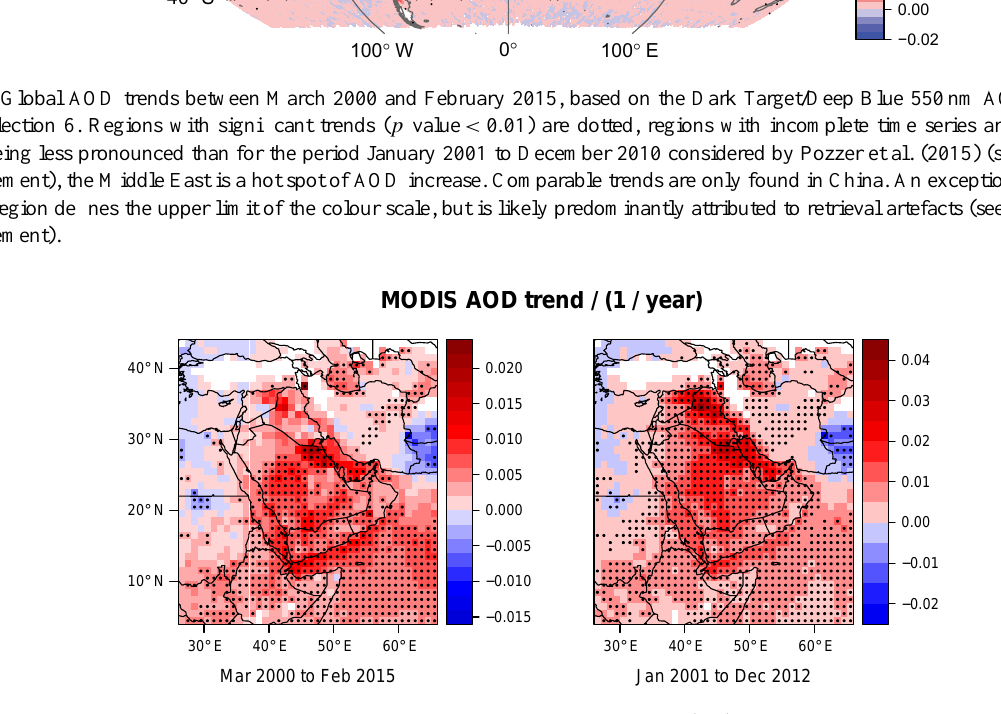
Figure 2. Pattern of Middle East AOD trends between March 2000 and February 2015 (left) and between January 2001 and December 2012 (right), based on the Dark Target/Deep Blue 550nm AOD from MODIS Terra, collection 6. Pixels with significant trend ( p value < 0 . 01) are marked with a dot. The same plot for the period January 2001 to December 2010 is shown in Fig. S2 in the